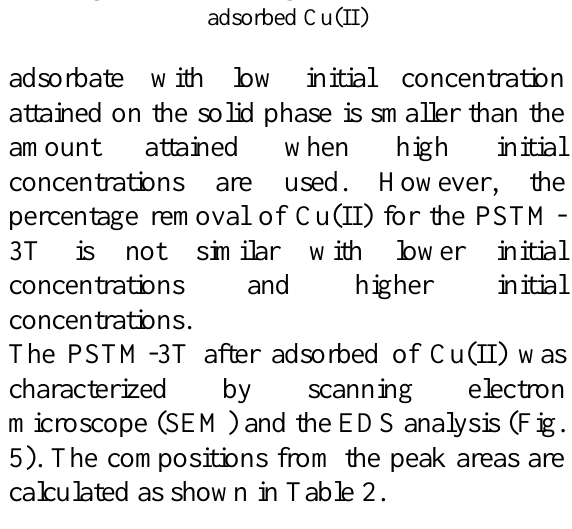
Fig.5. SEM/EDS images of PSTM-3T after adsorbed Cu(II)